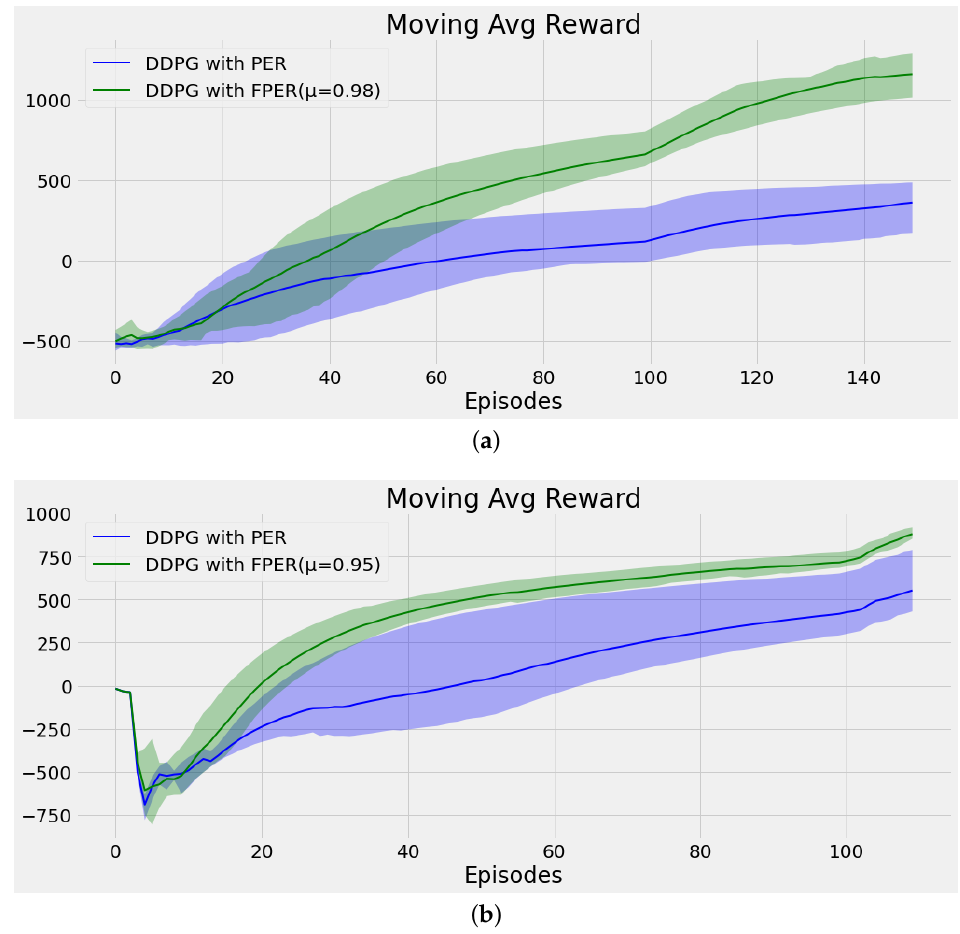
Figure 6. Learning curves in continuous control tasks. The shaded region represents the standard deviation of the average evaluation over five trials, and the thick line represents the mean of the average evaluation over five trials. ( a ) HalfCheetah-v1. ( b )